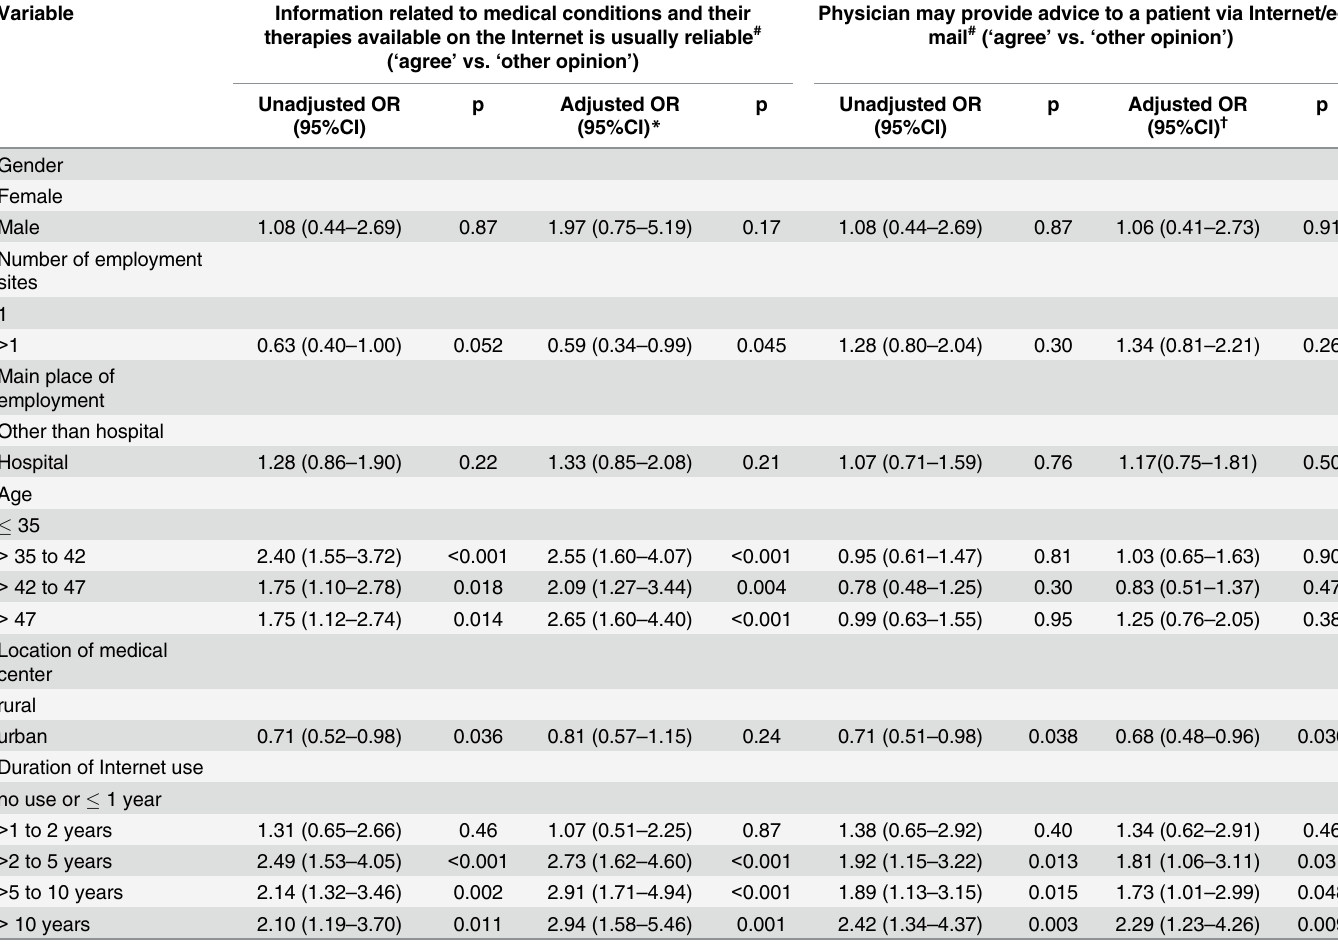
Table 4. The results of univariate and multivariate logistic regression modeling for opinions about the reliability of health-related resources on the Internet and about the use of Internet/e-mail for communication between a physician and a patient. Variable Information related to medical conditions and their therapies available on the Internet is usually reliable